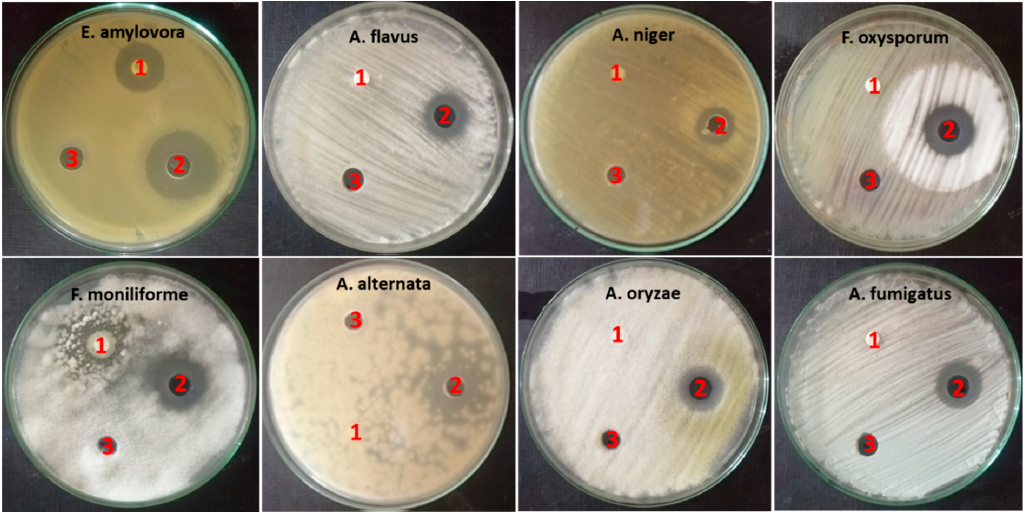
Figure 6. Antimicrobial activity of biosynthesized ZnO-NPs: (1) antibiotic controls, (2) ZnO-NP nanofluid and (3) base fluid.